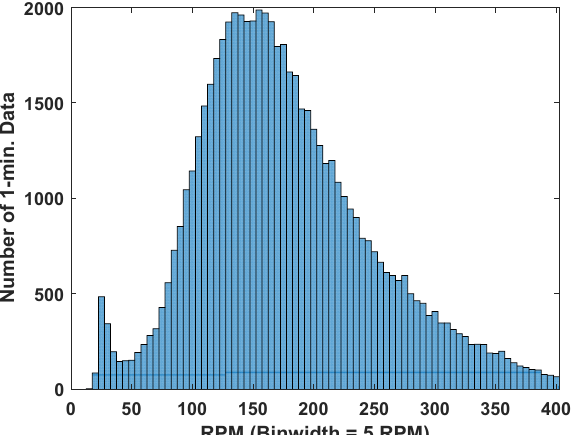
Figure 4. The number of 1-minute period data sets at each rotor speed binned at 5 RPM (excluding the idle and parked conditions).